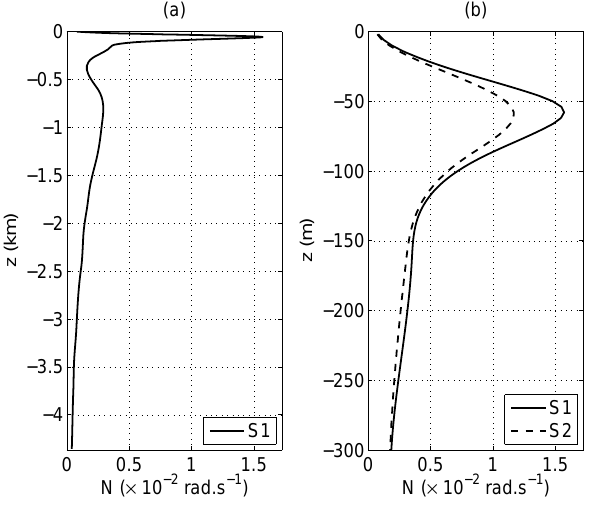
Fig. 1. (a) : Brunt-V¨ais¨al¨a profile for stratification S1 over the whole water depth (4370m). (b) : Brunt-V¨ais¨al¨a profiles for stratifications S1 and S2 from 0 to 300m depth. Below 300m depth, S1 and S2 are